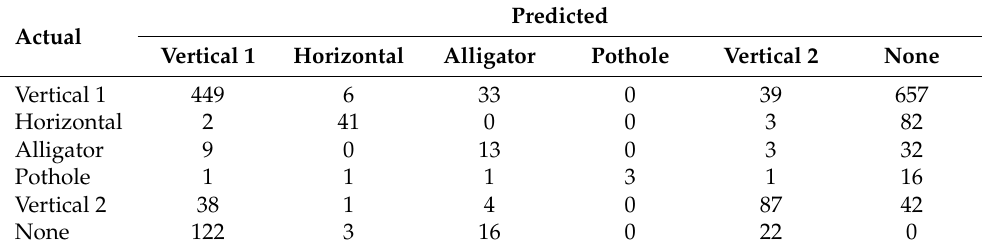
Table 8. Confusion matrix of Model 4.